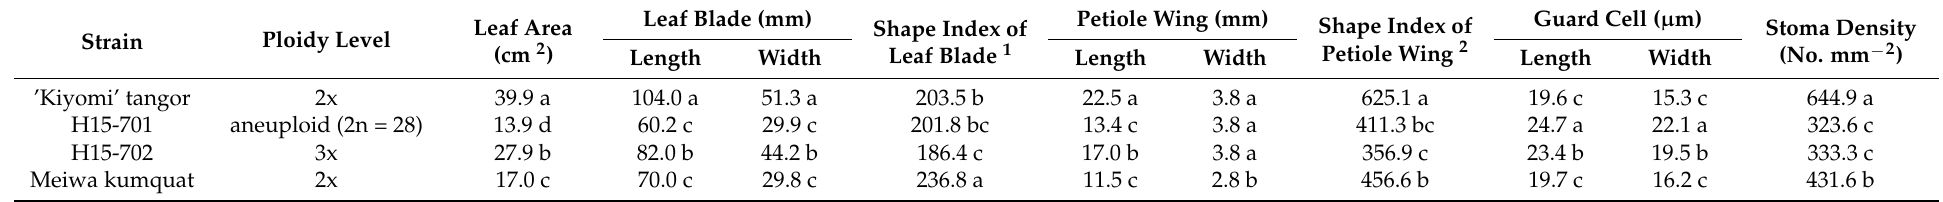
Table 3. Morphological characteristics of leaves in ‘Kiyomi’ tangor, Meiwa kumquat, and their hybrids. Different letters represent significant differences in Tukey’s multiple range test, 1% level (n = 20).